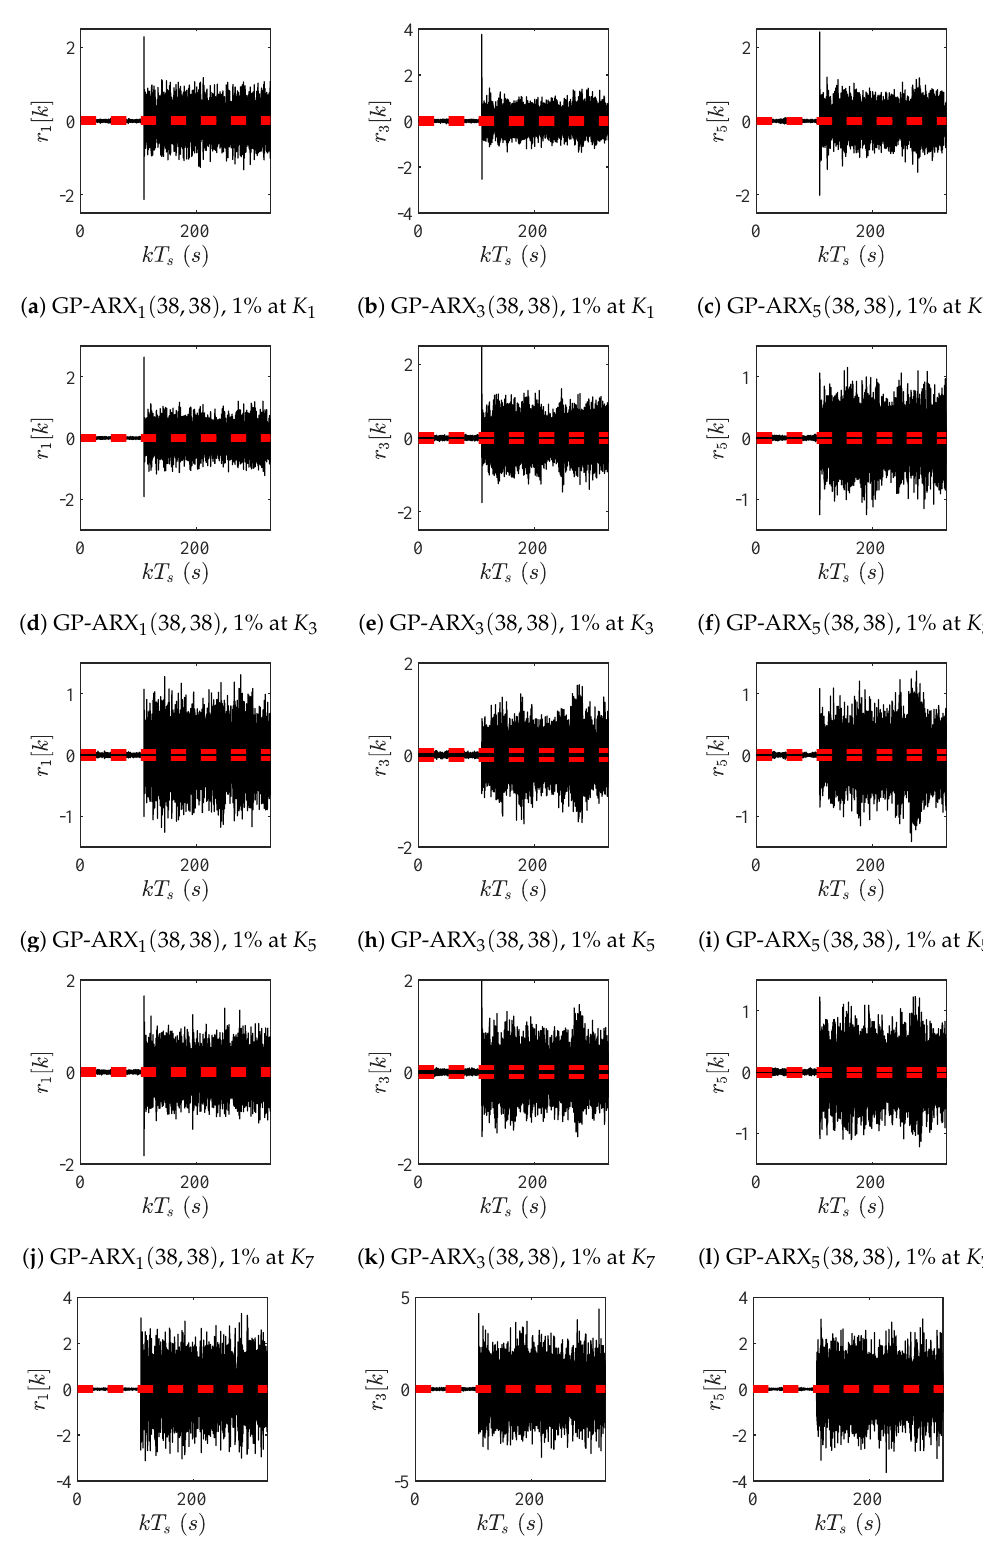
Figure 14. Spring-mass-damper: RGA time-series evolution during damage at t l =